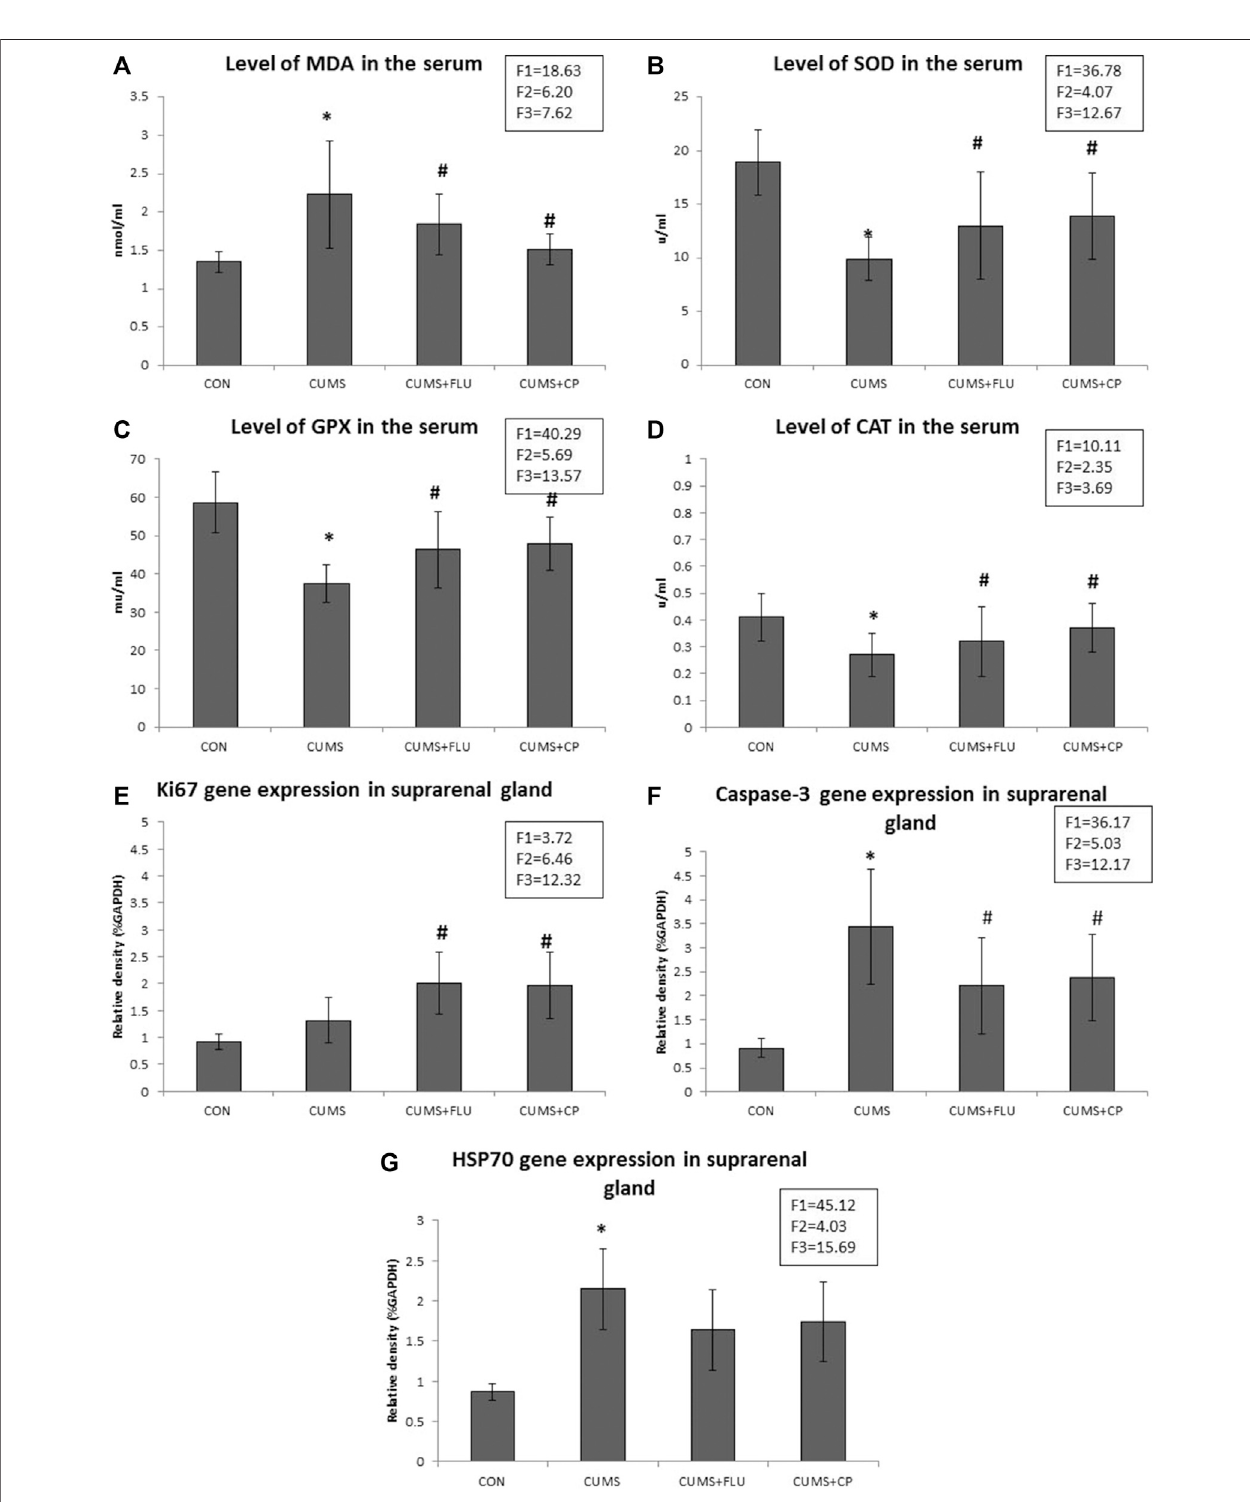
FIGURE 3 | Levels of MDA (A) , SOD (B) , GPX (C), and CAT (D) assessed in the serum of the studied groups using ELIZA. Levels of gene expression of Ki67 (E) , caspase-3 (F), and HSP70 (G) assessed in the suprarenal glands of the studied groups using qRT-PCR. Dataare analyzed using mixed-model two-way ANOVAbased ontheBonferroniposthoctest.Resultsareexpressedasmean ± SD( n (cid:1) 10),dF (cid:1) 36,F1 (cid:1) effectofstress,F2 (cid:1) effectoftreatment,F3 (cid:1) interactionbetweenstressand treatment. A p value < 0.05 was considered signi fi cant. * signi fi cance versus the control group (CON), # signi fi cance versus the chronic unpredictable mild stress (CUMS) group. CON: control, CUMS: chronic unpredictable mild stress, Flu: fl uoxetine, CP: Cucurbita pepo .